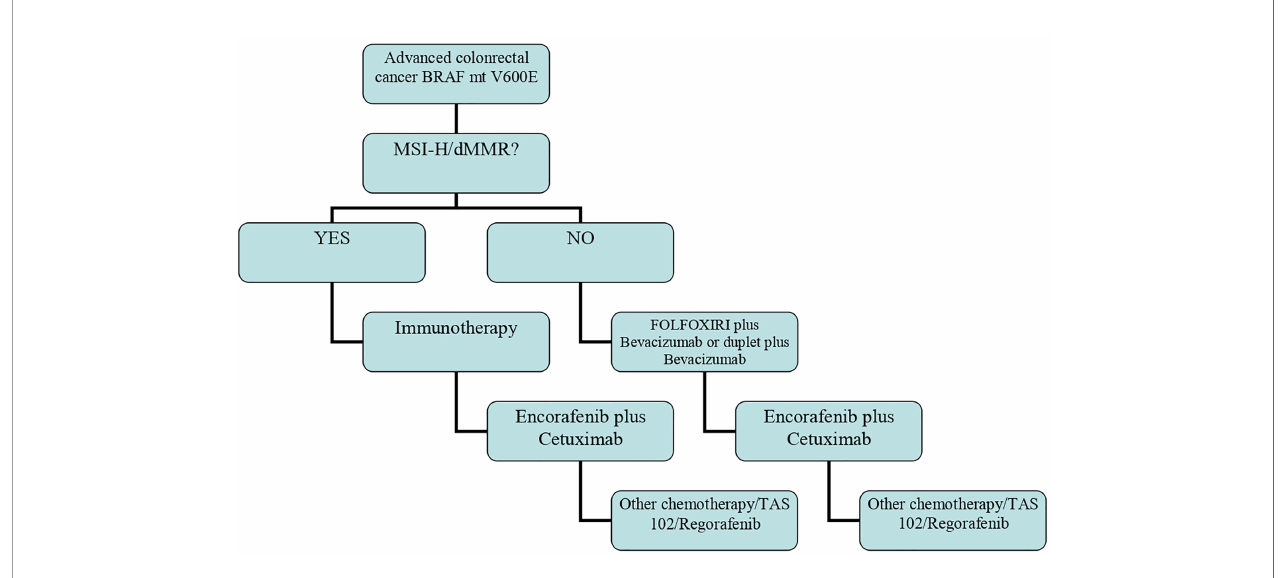
FIGURE 1 | Algorithm of therapy in BRAF mt advanced colon